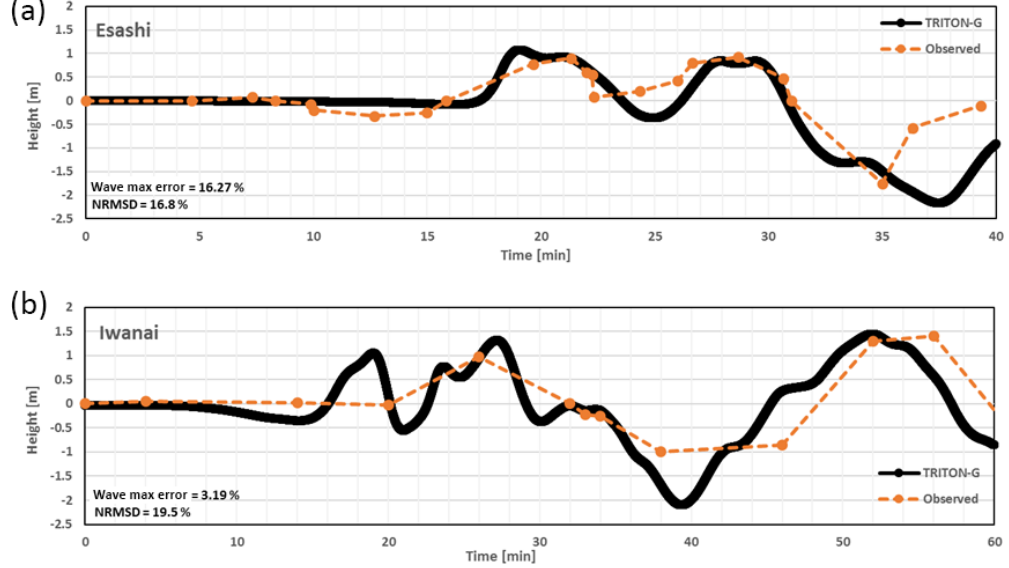
Figure 22. Water level comparison between observations and TRITON-G results for Esashi (a) and Iwanai (b) tide gauges.